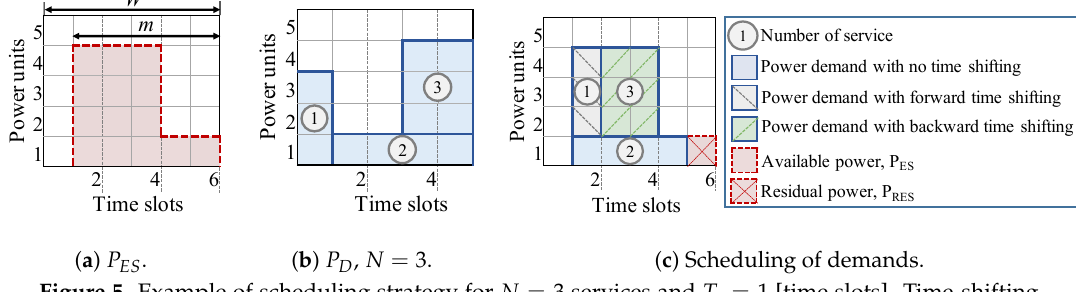
Figure 5. Example of scheduling strategy for N = 3 services and T s = 1 [time slots]. Time-shifting applied to services: T 1 s = 1 for S 1 , T 2 s = 0 for S 2 , and T 3 s bw